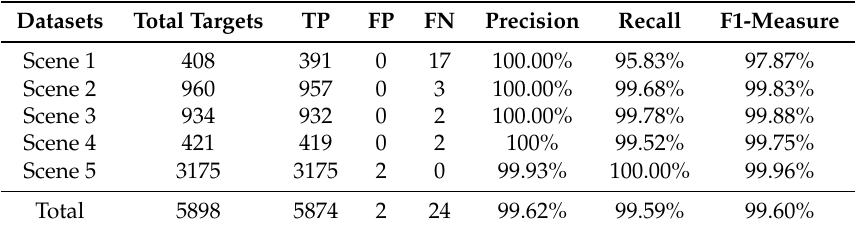
Table 3. The detection performance on the test